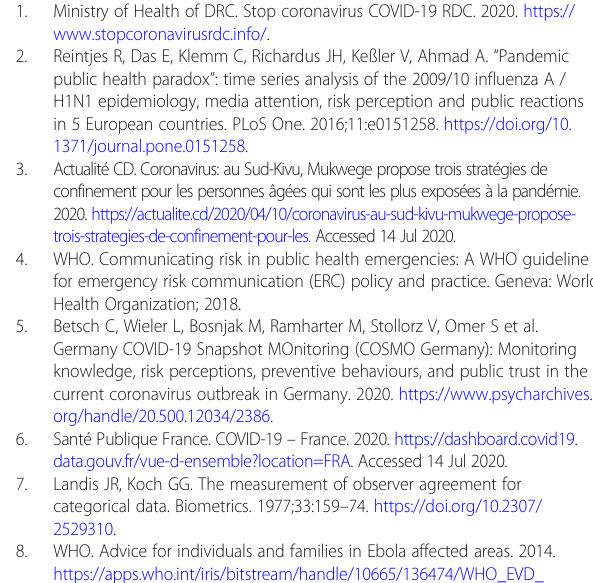
Additional file 1: Table S1. Statements and scores used by the observers in the streets of Bukavu, DRC, May 2020. Table S2. Spearman correlation coefficient between the main variables of the